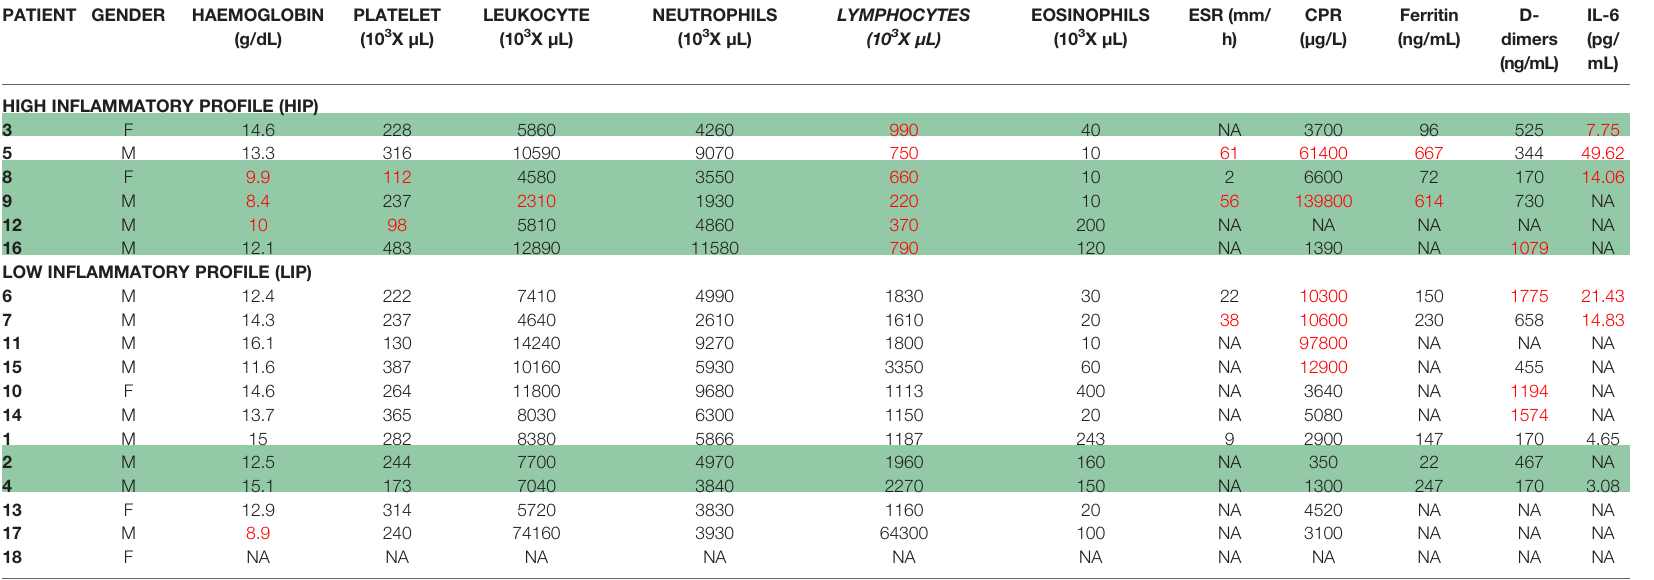
TABLE 1 | Summarizes serological features of the enrolled